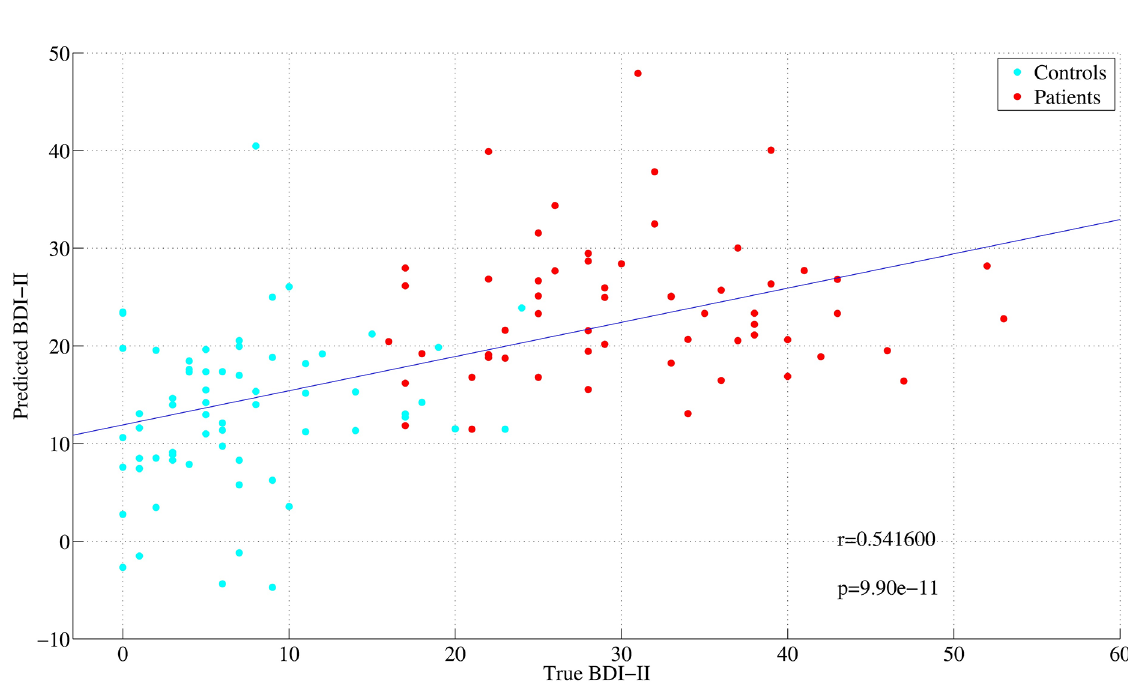
Fig 4. Actual and predicted values of BDI-II. BDI-II were well predictedby KPLS-Poly(2) with RMSE = 9.56 and r = 0.541 ( p < 10 − 10 ). Red and blue points represent patients and healthycontrols, respectively.